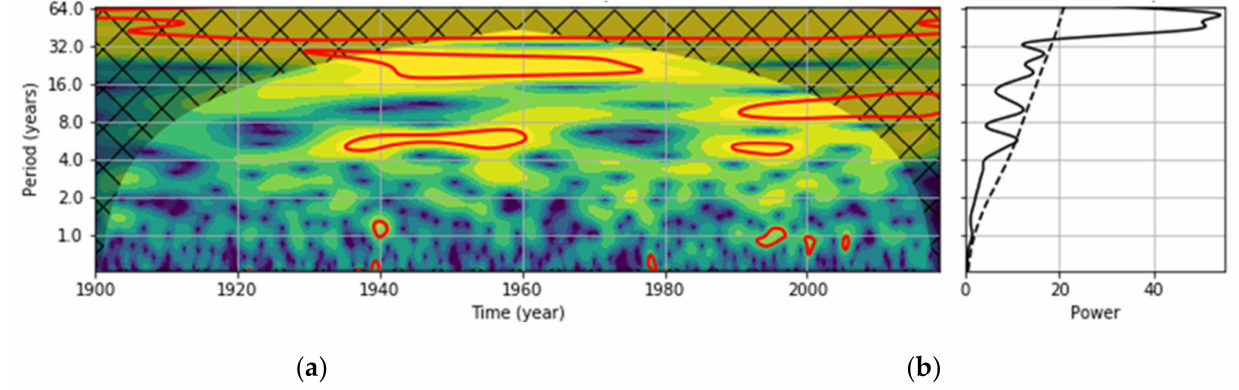
Figure 18. Results of wavelet analysis of the PDO index, illustrating the quasi-periodic behavior: ( a ) wavelet power spectrum and ( b ) global wavelet